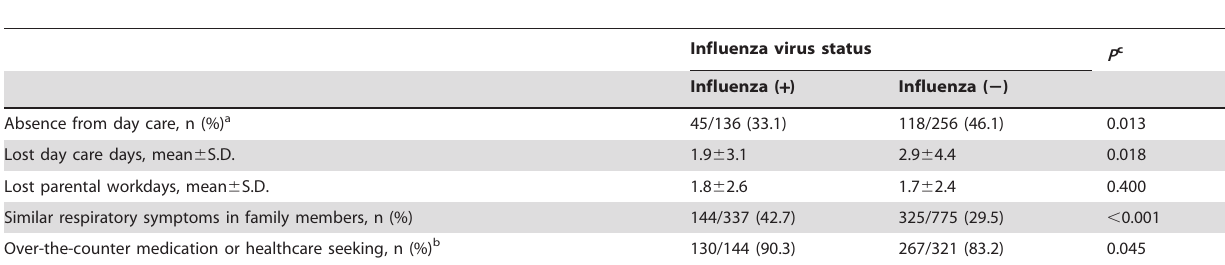
Table 4. Socio-economic impacts of influenza-like illness (ILI) on children and their families, by influenza virus